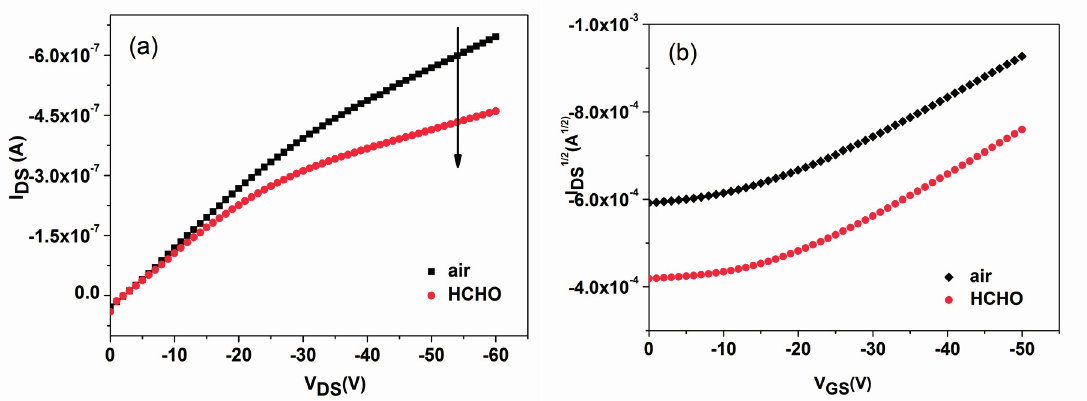
Figure 8. The ( a ) output and ( b ) transfer characteristics curves of P3HT-ZnO film OTFT sensor exposed to 100 ppm HCHO compared with those in air.